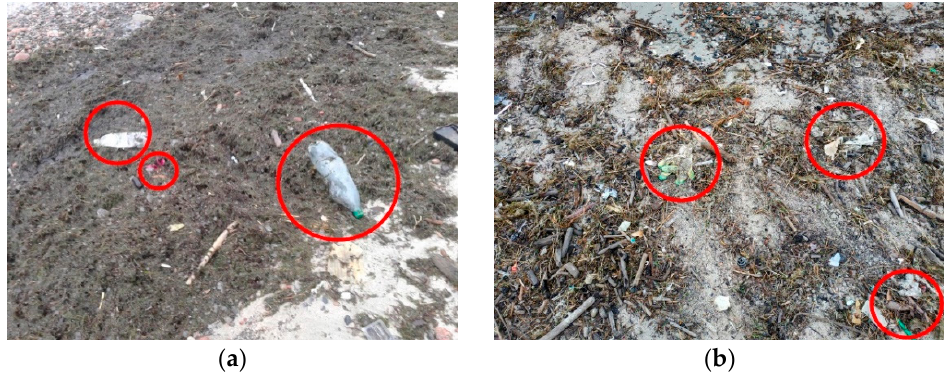
Figure 1. Photos of the beach in the Kulikovo village with a massive wash-outs of marine debris: ( a ) plastic bottles and ( b ) other plastic and anthropogenic litter (highlighted by red circles).